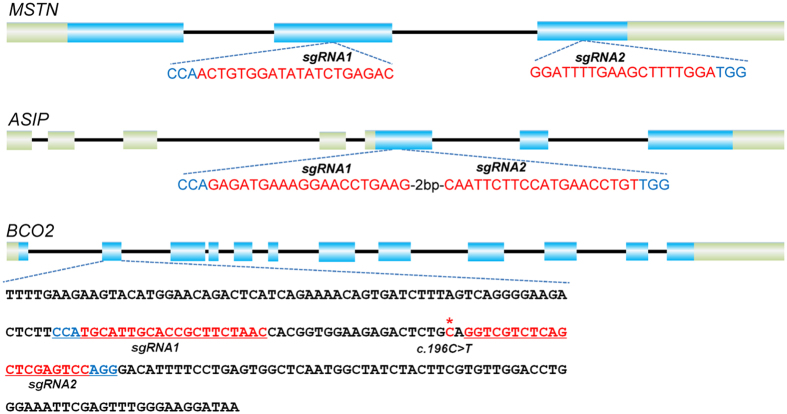
Schematic diagram of genetic structures of MSTN, ASIP and BCO2 and their targeting loci of sgRNA:Cas9.sgRNAs targeting sites are highlighted in red, whereas PAM sequences are highlighted in blue. The asterisk indicates the location of the c.196C > T mutation in the BCO2 gene.